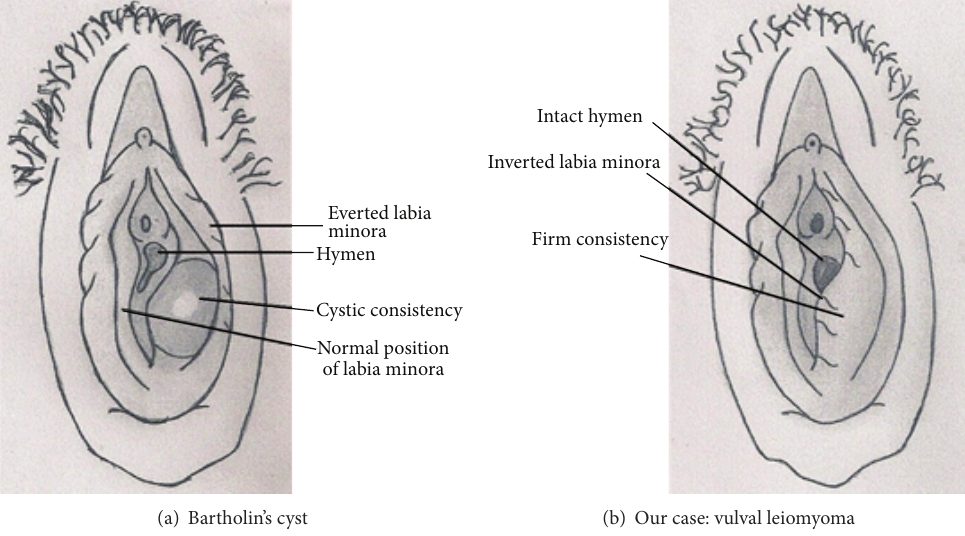
Figure 2: Crucial features to look for in a case of vulval